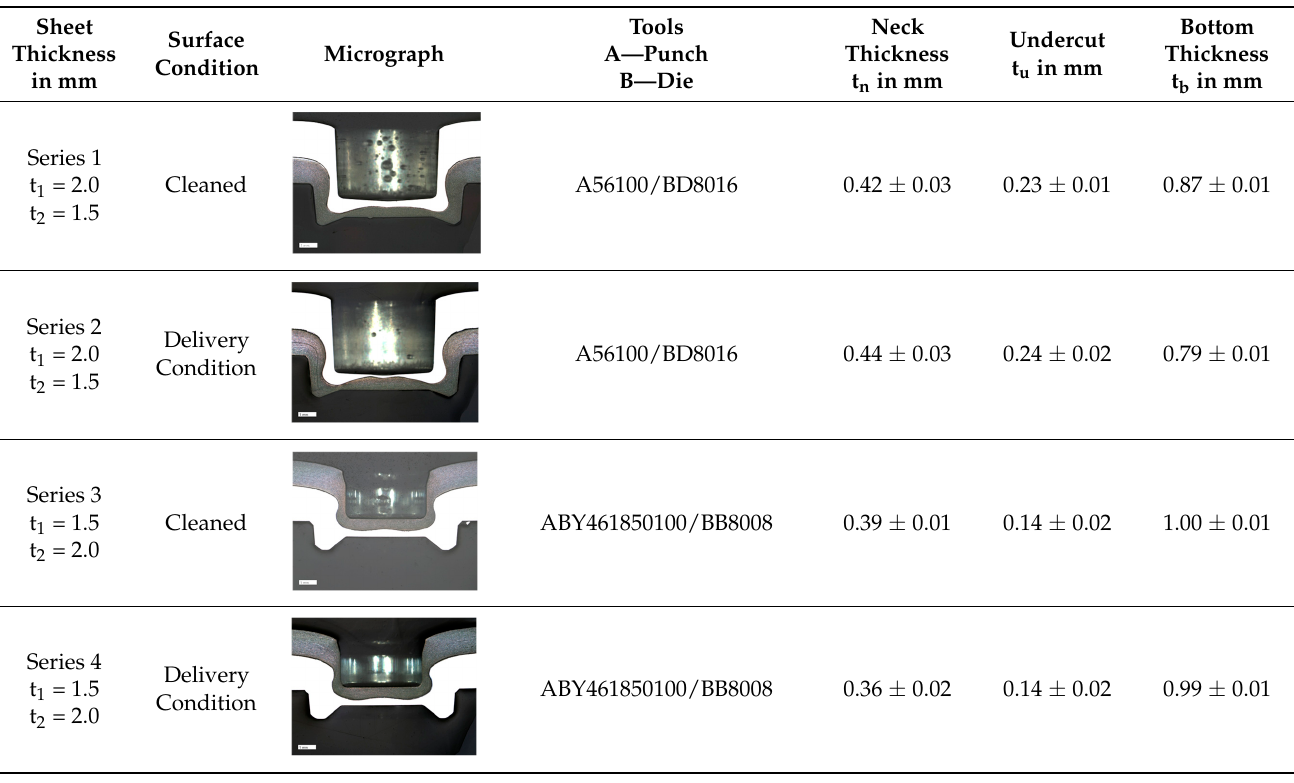
Table 2. Design and dimensioning of the clinch joints investigated (seven specimens per series).